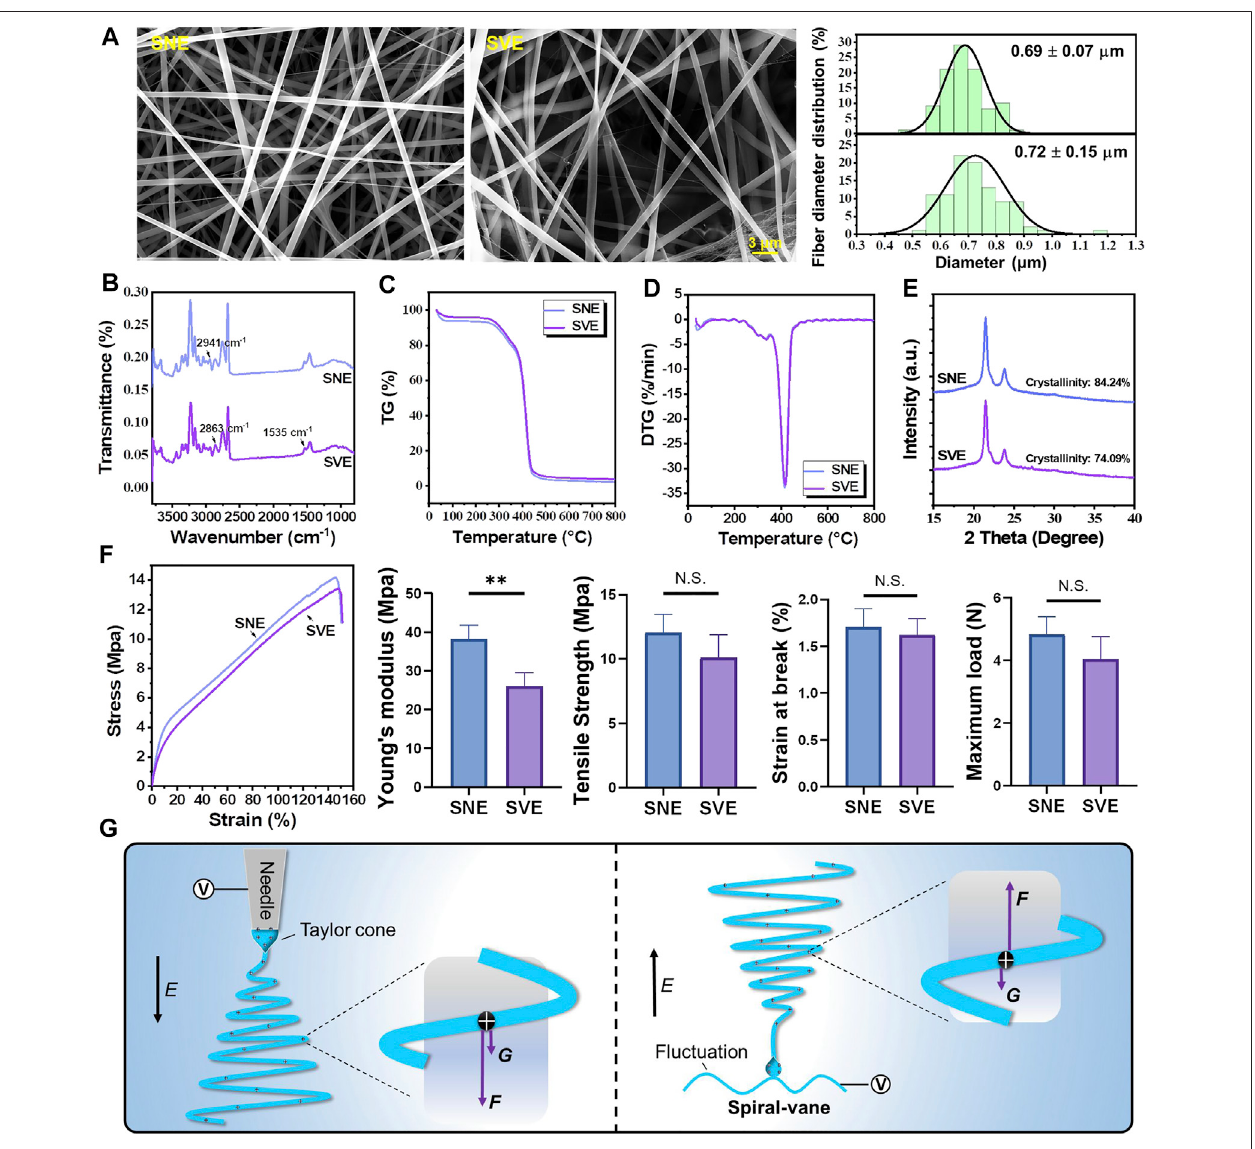
FIGURE 2 | Characterization of the PCL/Gel nano fi bers produced by SNE and SVE: (A) SEM and the distribution of fi ber diameter; (B) FTIR; (C,D) thermogravimetry and derivative thermogravimetry; (E) XRD and crystallinity; (F) stress – strain curves, Young ’ s modulus, tensile strength, strain at break, and maximum load; and (G) the proposed mechanisms for molecule elongation and crystallinity. E indicates the direction of the electric fi eld. F and G represent the electric force and gravity force actioned on jets, respectively.